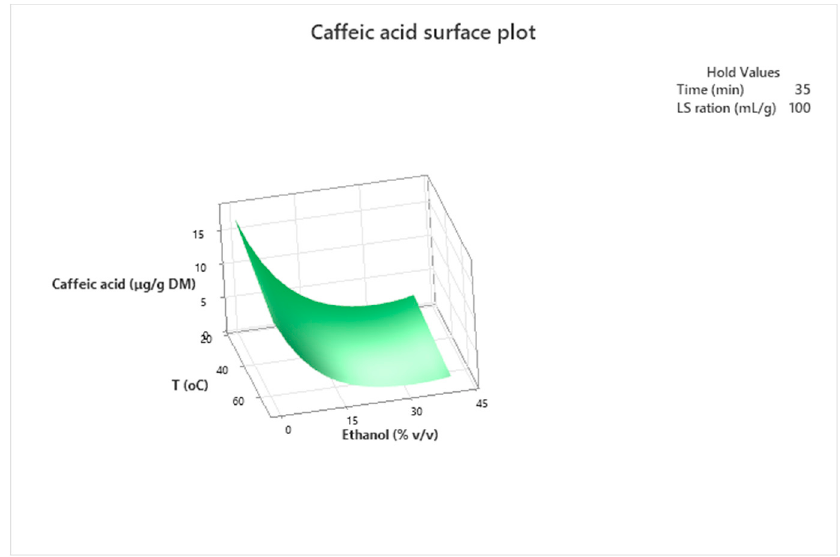
Figure 5. 3D response surface plot of the caffeic acid (response variable) in µ g/g of dry matter (DM) of parsley as a function of Temperature (X 1 ) in Celsius degrees (°C) and ethanol concentration in % v / v while holding time at 35 min and ratio of solvent to dry parsley (LSr) at 100.